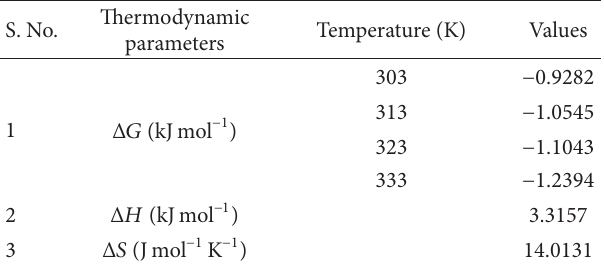
T 3: ermodynamic Parameters for �dsorption of �uoride onto ZIWSC.